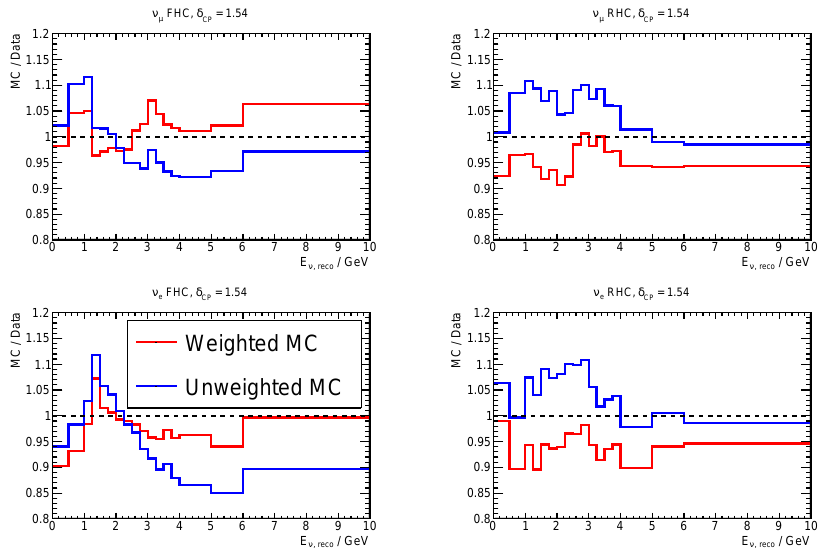
Figure 72. Ratio of NuWro mock data to weighted and unweighted MC samples. The blue line is the nominal MC while the red line is the MC with the additional near detector-derived